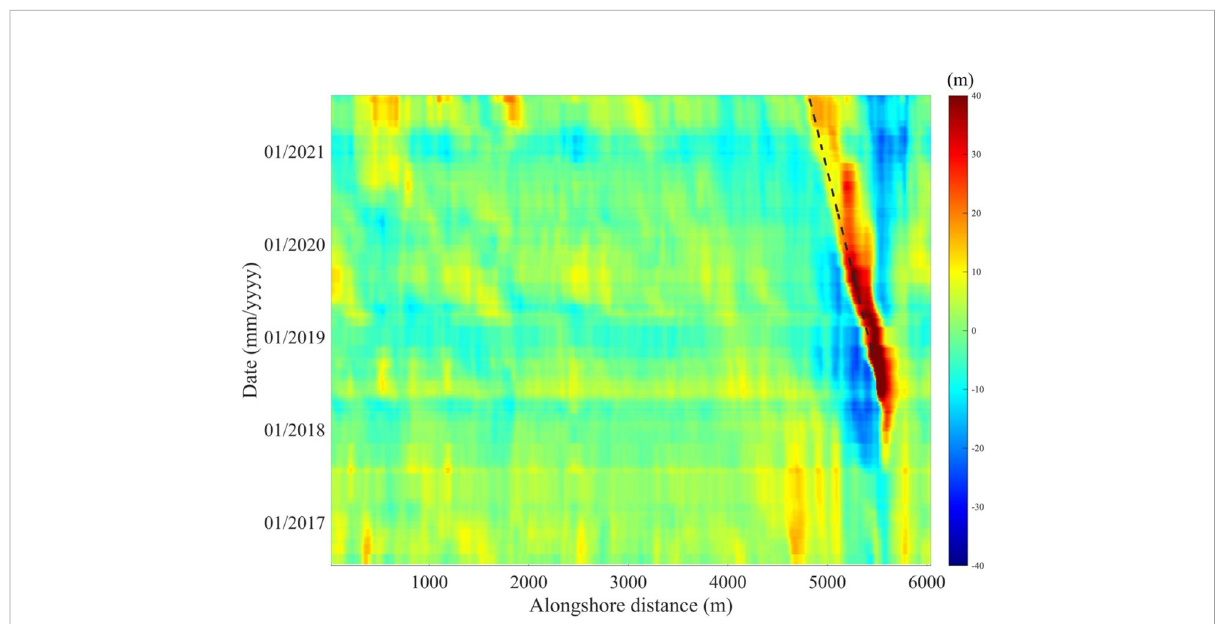
FIGURE 11 Spatial (alongshore) and temporal evolution of the relative beach width change, estimated from Sentinel-2, in the vicinity of the geotextile breakwater deployed in San Miguel. The dashed lined shows the sediment dispersion pattern after the breakwater